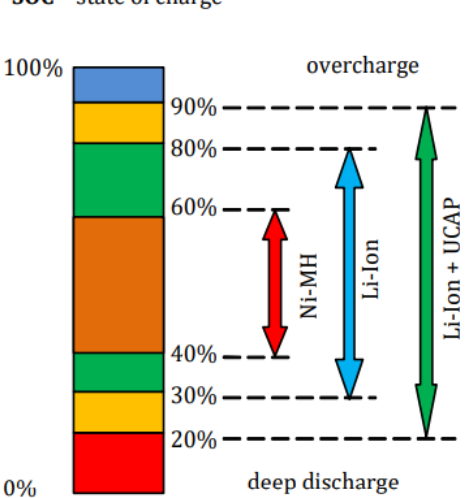
Fig. 4. Conditions for charging and discharging typical battery systems in hybrid drive systems [1] The energy storage system was placed on the roof of the tractor cab due to the sufficiently large mounting surface of the frame attached to the brackets welded to the cab sup- porting pillars. The battery system with dimensions of ap- prox. 2000 × 1600 × 400 mm holds 784 batteries with di- mensions of 38 × 146 mm each (Fig.